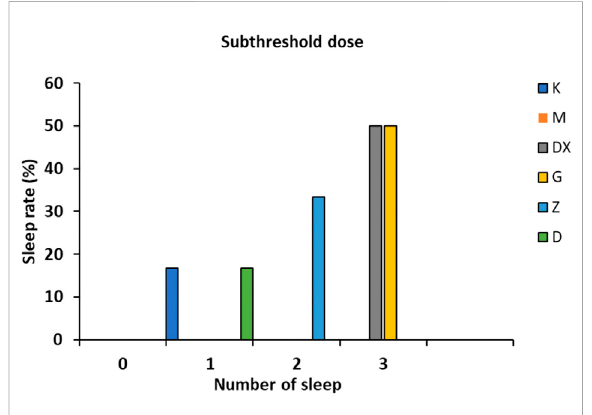
FIGURE 3 Effects of R-S on the subthreshold dose of pentobarbital sodium synergistic sleep experiment in rats with insomnia.